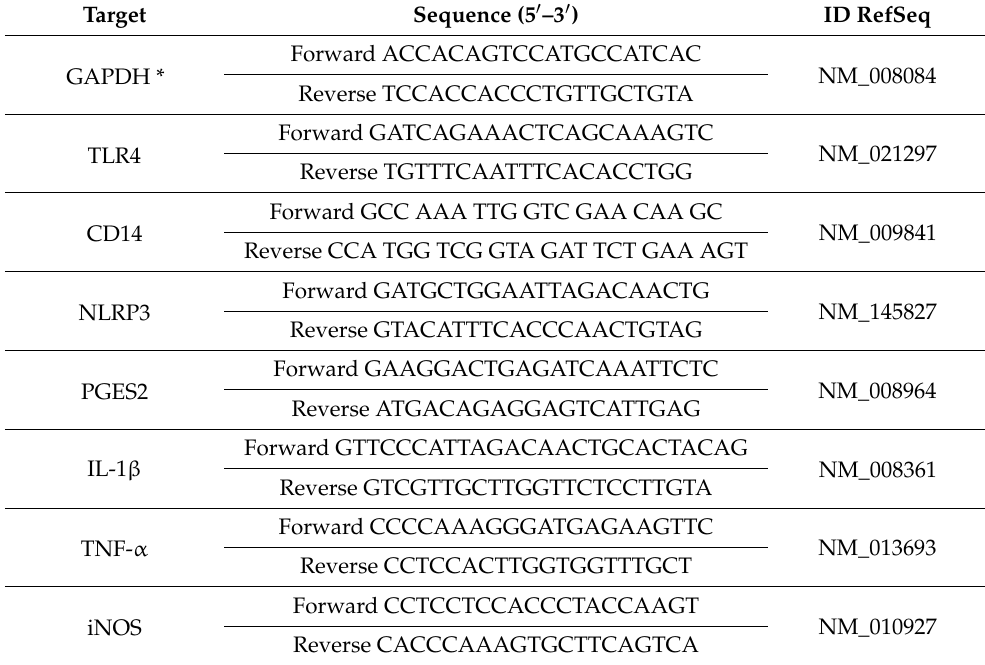
Table 1. Primer used for Real-time